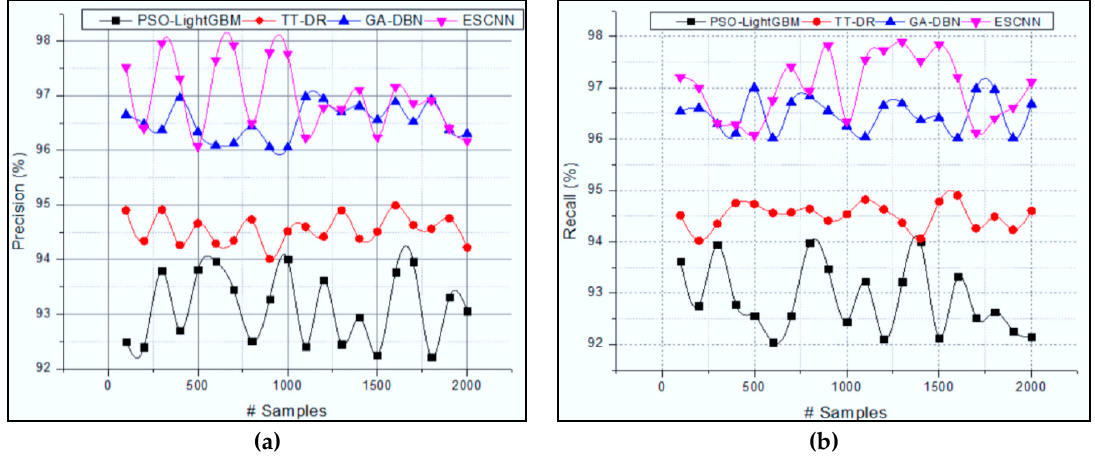
Figure 6. Classification results: ( a ) Precision and ( b ) Recall.